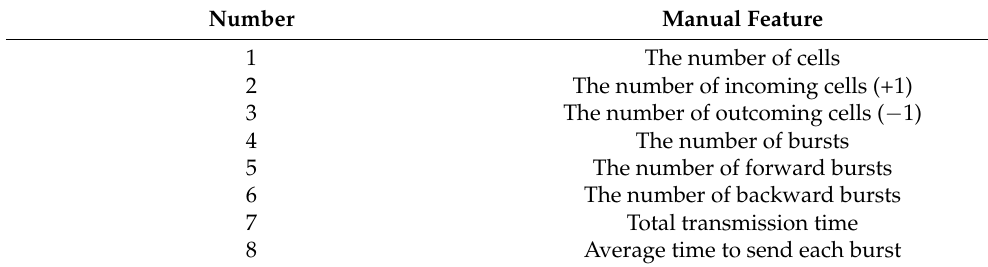
Table 1. Eight Manual